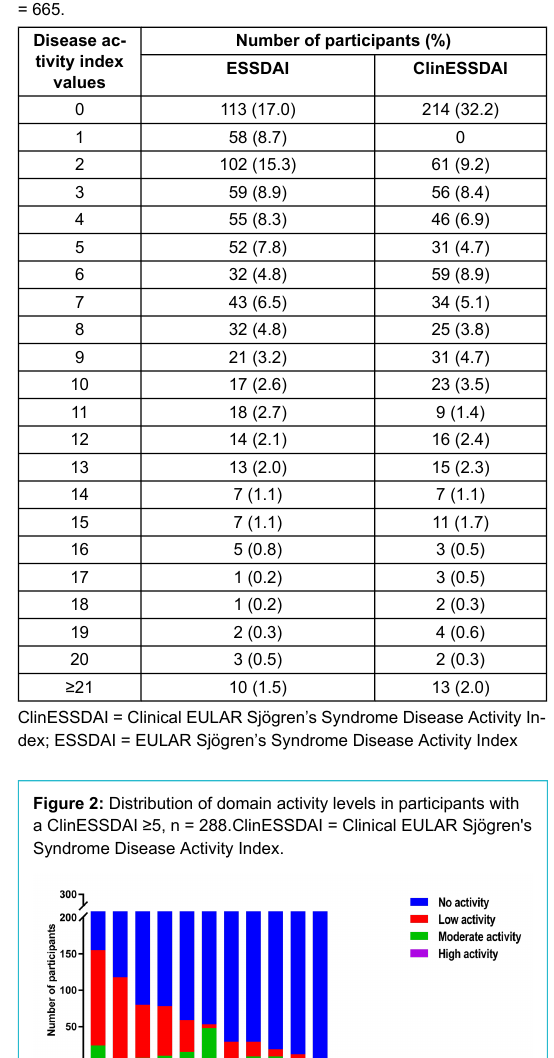
PNS = peripheral nervous system * Statistically significant with Bonfer- roni correction for multiple comparisons testing. Rho coefficient calcu- lated with Spearman’s